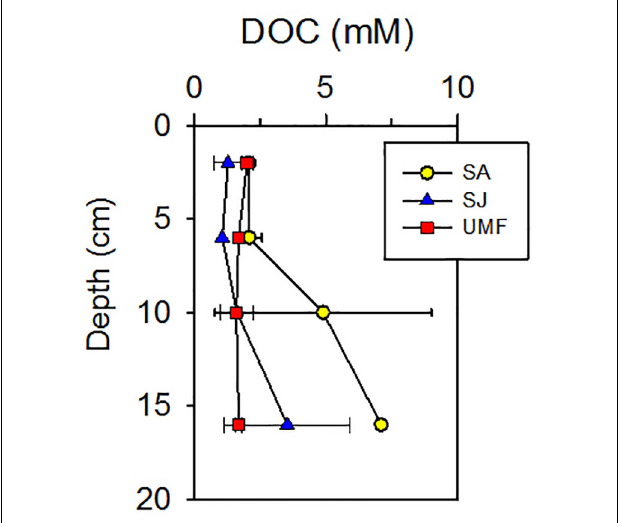
FIGURE 3 | Vertical profiles of dissolved organic carbon (DOC) in sediment vegetated by Spartina anglica (SA) and Suaeda japonica (SJ) and unvegetated mud flats (UMF). Error bars indicate a mean ± 1 SD from triplicate